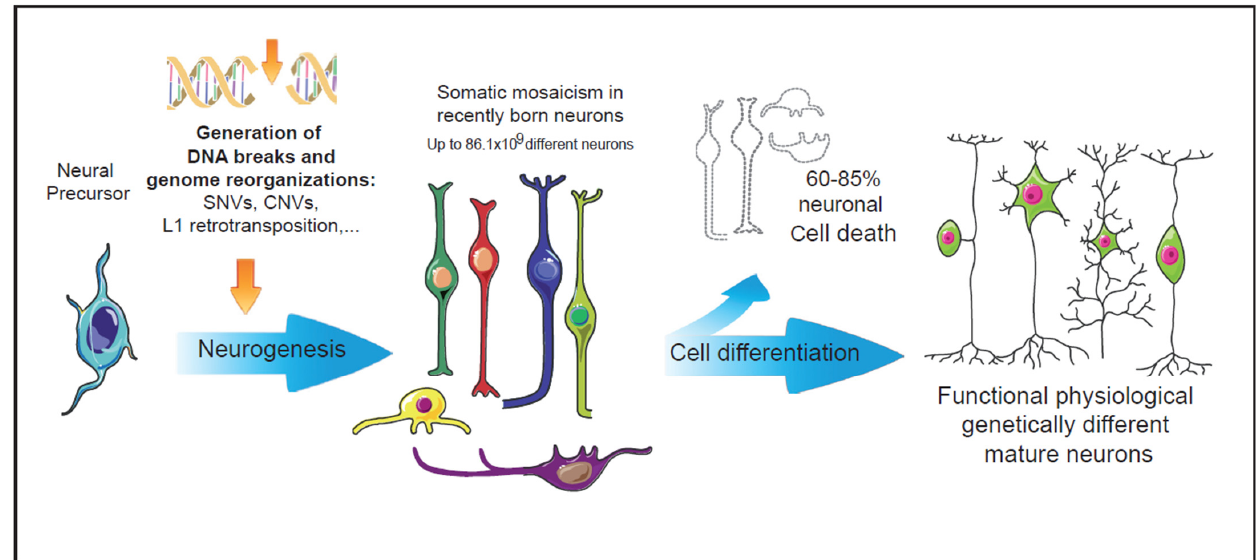
Figure 1. Intrinsic events during early neurogenesis that may contribute to somatic mosaicism and functional diversity in the mature nervous system. In the nervous system, neuronal genetic diversity seems to arise intrinsically during early neuronal differentiation. Diverse genetic alterations have been observed in healthy neurons, most of them involving the generation and repair of DNA double strand breaks. The pool of neurons with cell-unique differences in their DNA could be even larger than the vast numbers of antibodies generated by the V(d)J recombination in the immune system [14]. During neuronal differentiation, more than 60% of the recently generated neurons undergo cell death events [15]. The surviving neurons, many of them carrying genetic alterations, may configure a functional repertoire characterized by the physiologically generated somatic mosaicism.